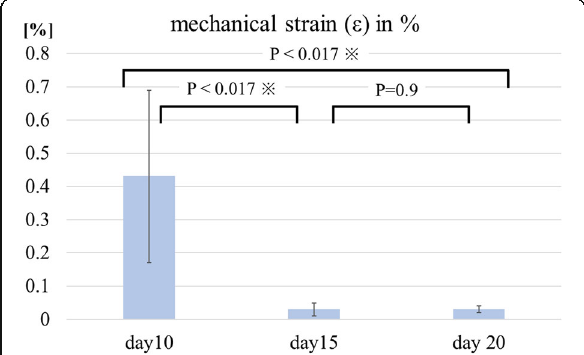
Fig. 4 Graph of mechanical strain ( ε ) of the tendon gel after applying traction force for 24 h. mechanical strain ( ε ) of tendon extension after applying traction on days 10, 15, and 20. mechanical strain ( ε ) of the tendon gels are significantly different between the day 10 and 15 groups and the day 10 and 20 groups